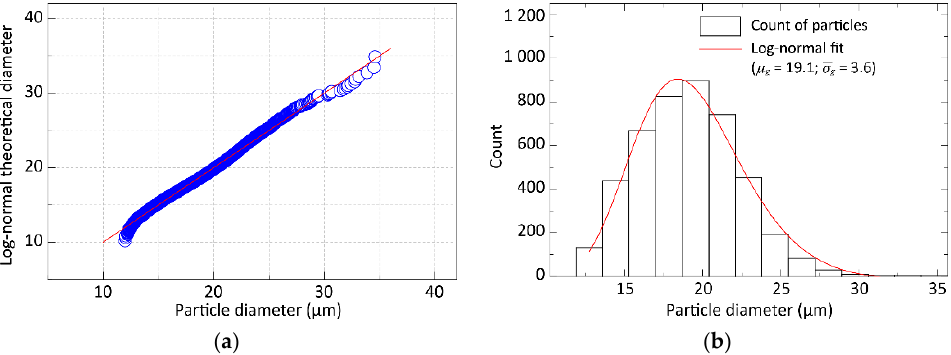
Figure 2. Log-normal distribution fitted to the particle size distribution of Type-5 solder paste: ( a ) Lognormal Q-Q plot of particle diameter; ( b ) Histogram plot of particle size distribution.